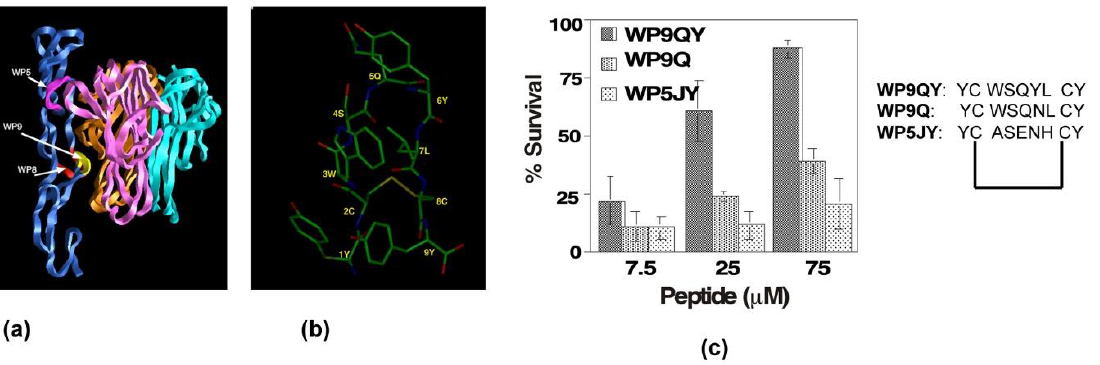
Figure 4. Design and development of anti-TNFR1 complex peptide inhibitor. ( a ) Three-dimensional structure of TNFR1-TNF receptor complex in ribbon representation. TNFR1 is shown in blue; each protomer of TNF α is shown in three-different colors. Three main contact loops, WP5, WP9, and WP8, involved in forming stable trimeric complex are indicted. The major contact, WP9, is highlighted in yellow. ( b ) Solution structure of WP9 is shown. ( c ) Inhibitory effects of peptides inhibitors derived from the structures of WP9 and WP5 loop in a cell survival assay. WP9QY inhibits TNF α -induced apoptosis in L929 cells. At 75 μ M, WP9QY protected nearly 90% of cells from TNF α -induced cell death.